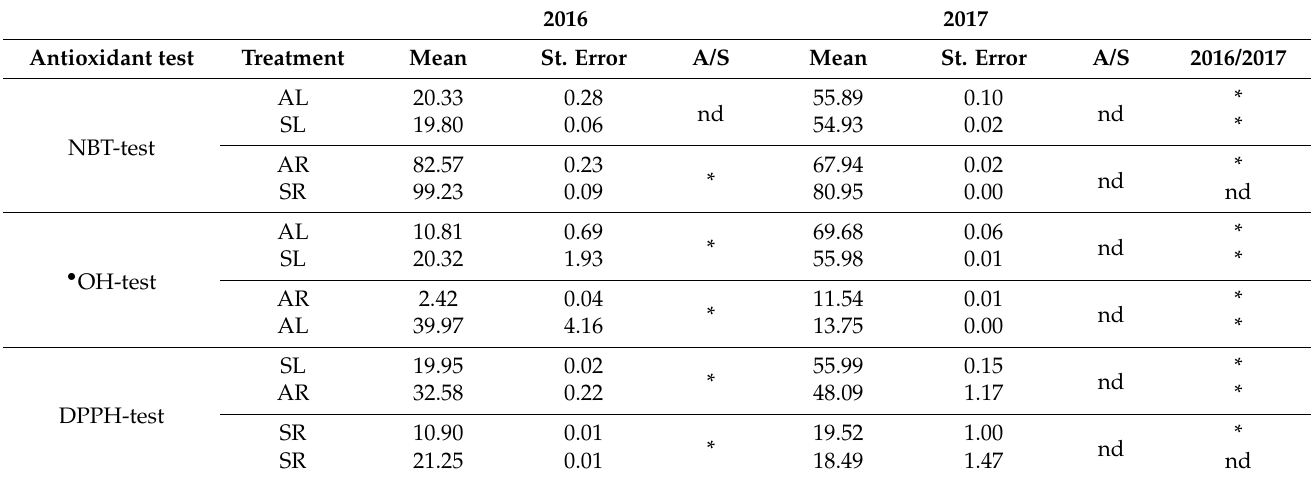
Table 5. Antioxidant capacity (% of neutralized radicals) in asymptomatic (A) and symptomatic (S) carrot leaves (L) and roots